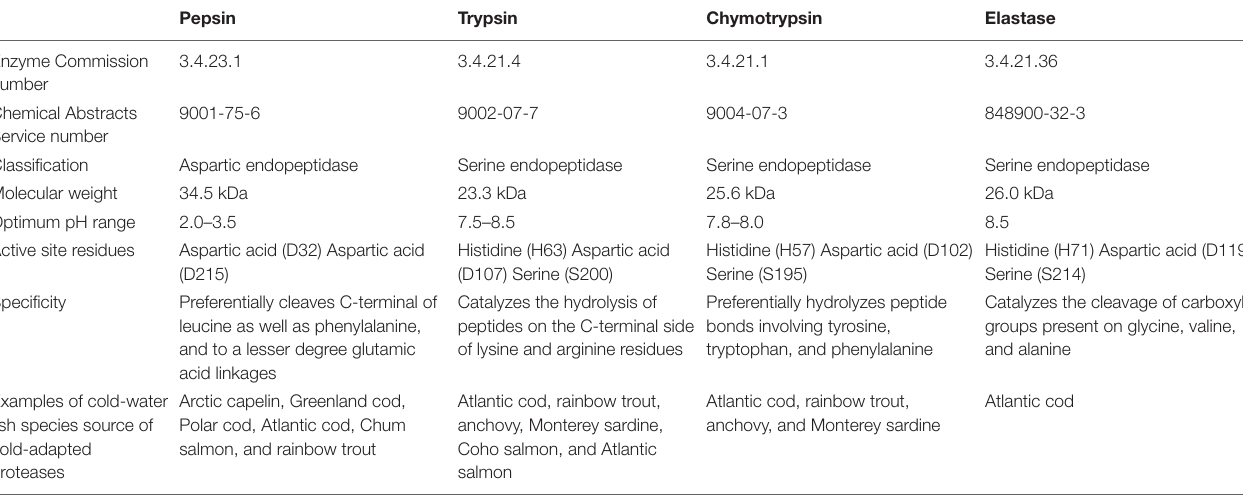
TABLE 1 | General characteristics of major digestive proteases present in fisheries and aquaculture